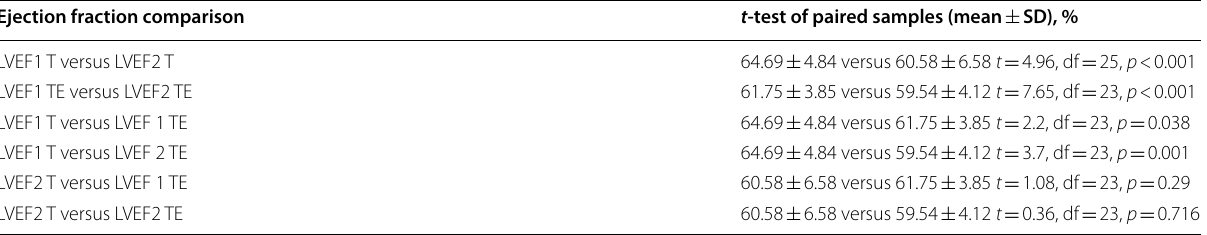
We used Student’s t -test of paired samples to compare LVEF before and after trastuzumab and trastuzumab emtansine protocols